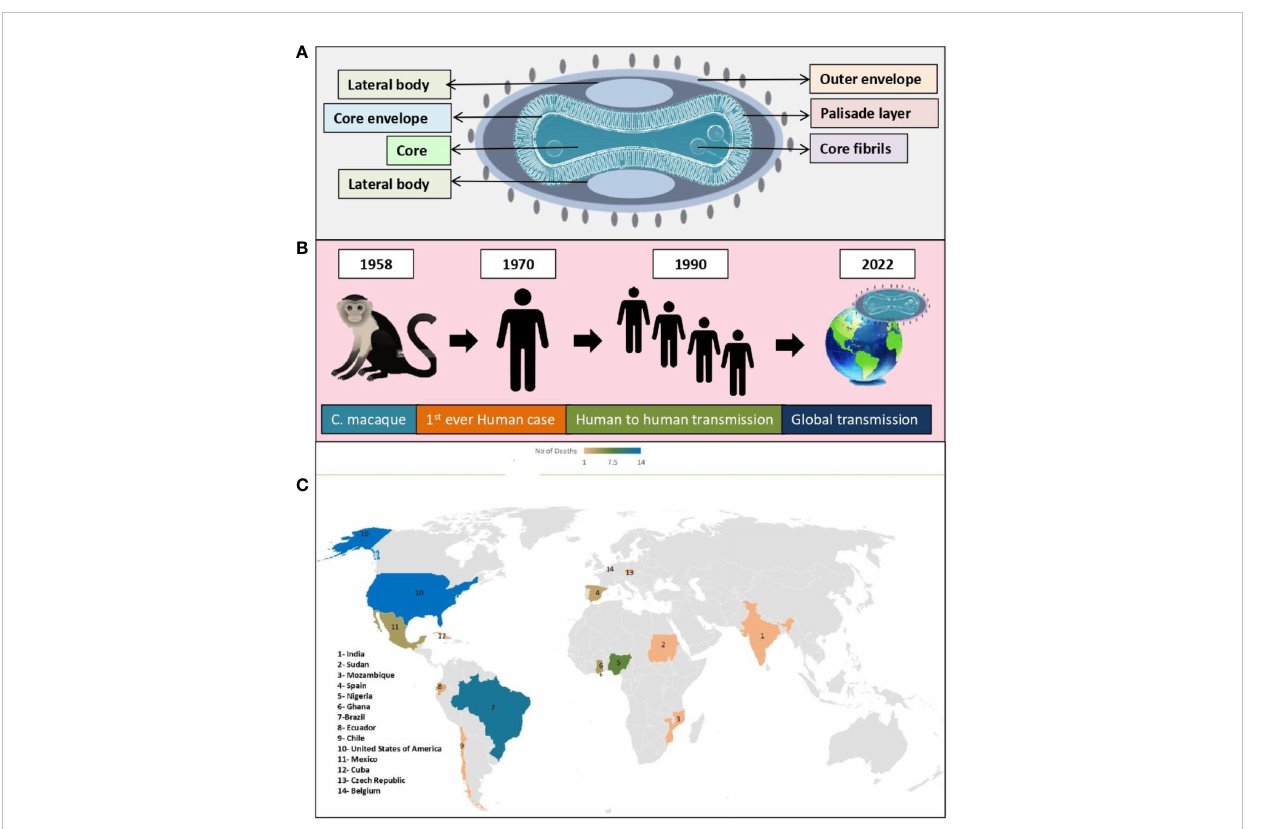
FIGURE 3 Monkeypox virus; (A) Structure, (B) Global transmission, (C) Reported death cases of different geographical areas (till 24, November,